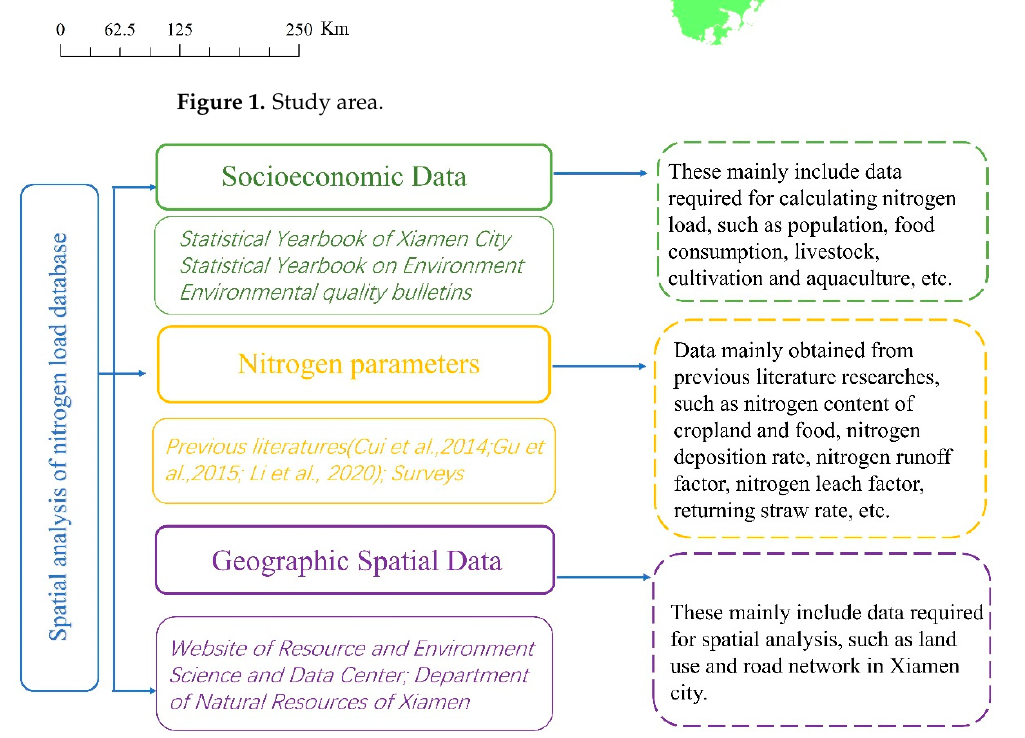
Figure 1. Study area.